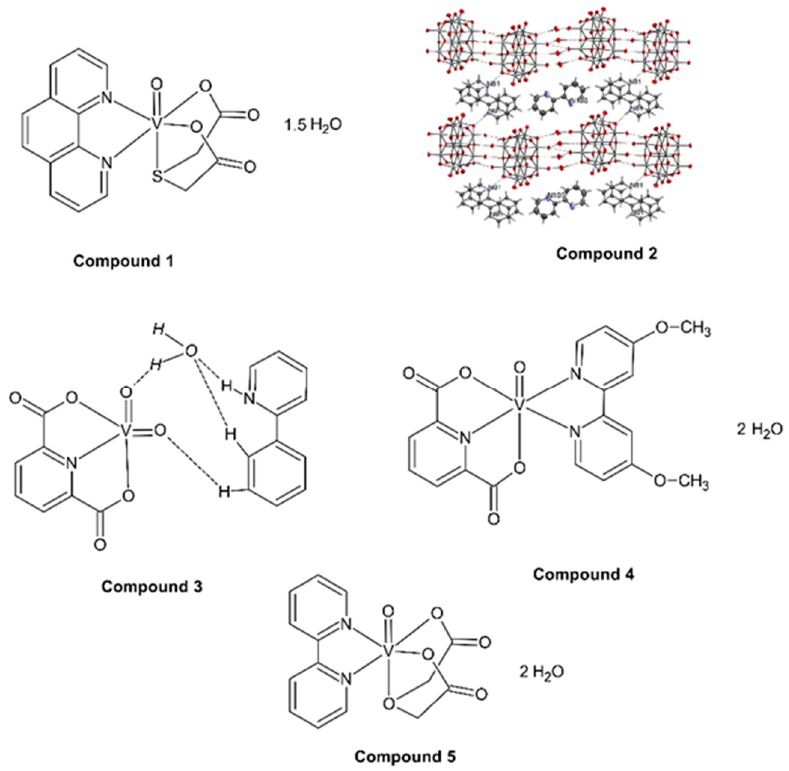
Figure 1. Molecular formulas of [VO(TDA)phen] • 1.5 H 2 O (Compound 1) (TDA = thiodiacetate), (phen = 1,10-phenanthroline), oxovanadium(IV) microclusters with 2-phenylpyridine (Compound 2), [VOO(dipic)(2-phepyH)] • H 2 O (Compound 3) (dipic = pyridine-2,6-dicarboxylate anion), (2- phepyH = 2-phenylpyridine), [VO(dipic)(dmbipy)] • 2H 2 O (Compound 4), (dmbipy = 4,4 ′ -dimethoxy-2,2 ′ -dipyridyl) and [VO(ODA)(bipy)] • 2 H 2 O (Compound 5) (ODA = oxydiacetate), (bipy = 2,2 ′ -bipyridine).